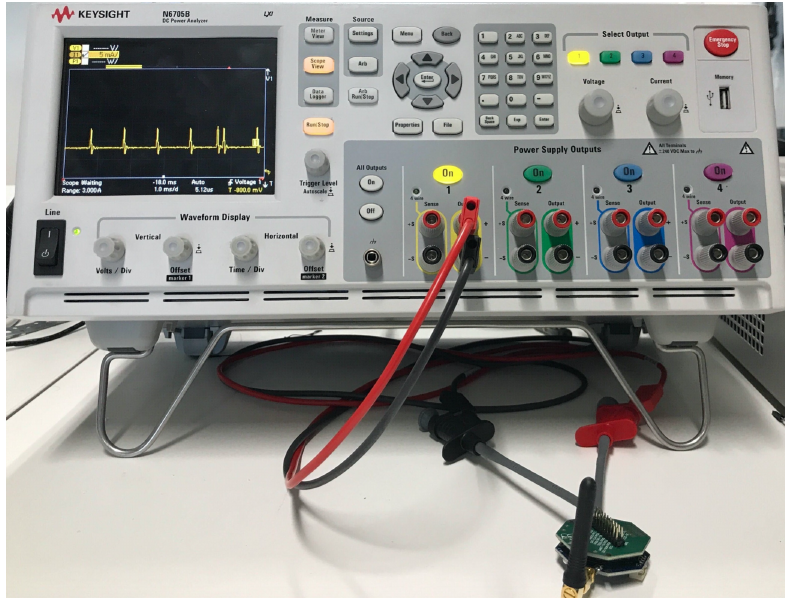
Figure 4. Experiment setup for energy measurement using Keysight N6705B DC Power Analyzer.